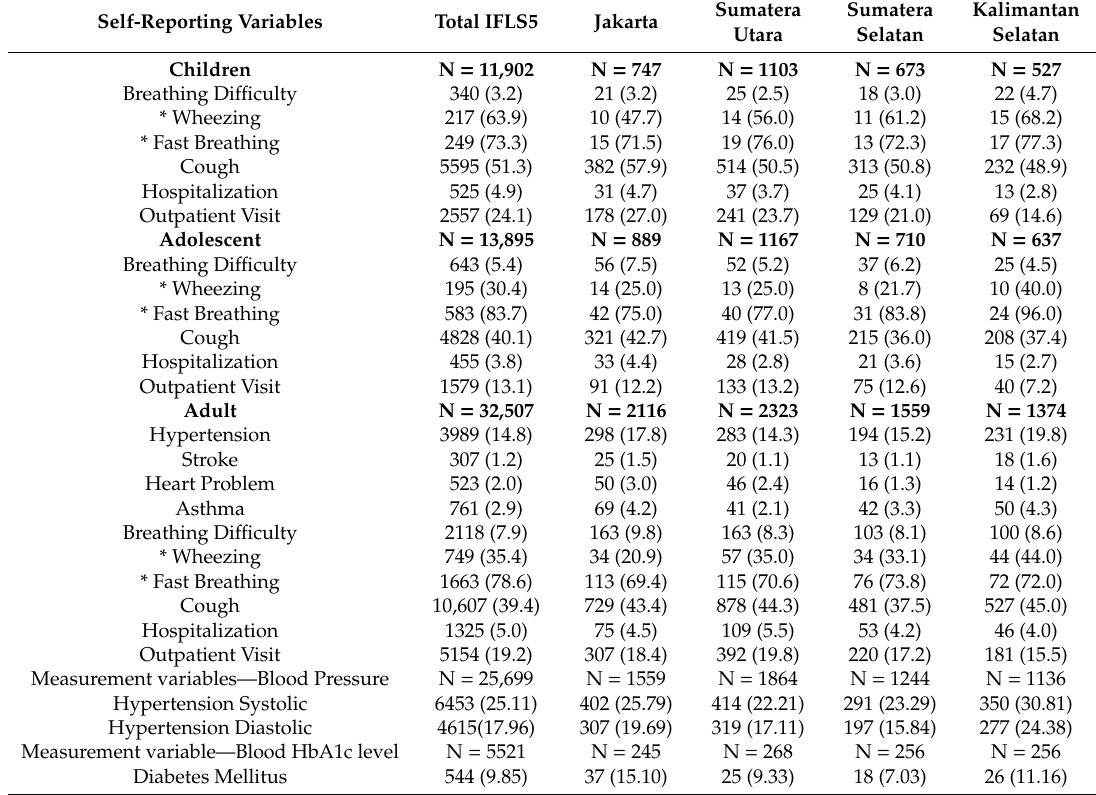
Table 3. Prevalence # of Health Outcomes from IFLS5 (N